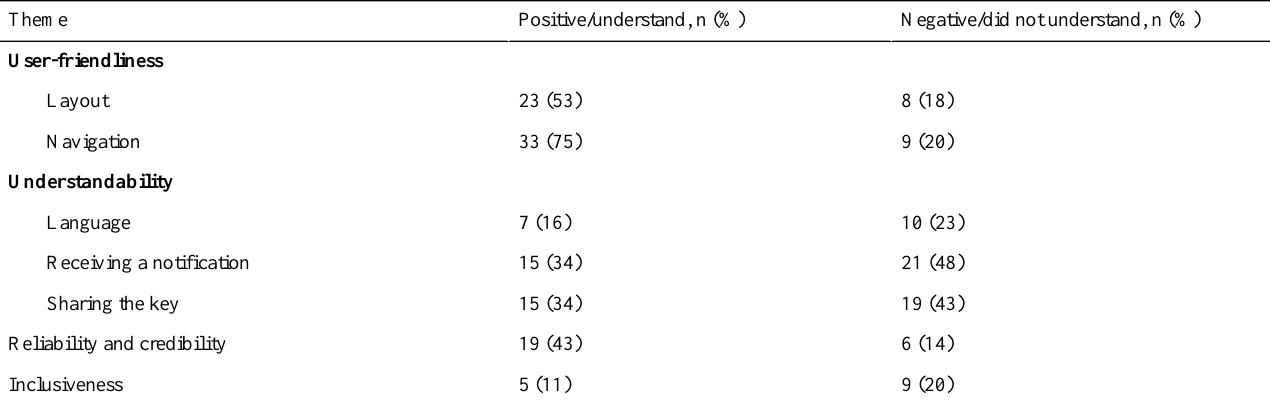
Table 2. Number of participants who stated a positive or negative comment about the CoronaMelder per topic (user-friendliness, understandability, reliability and credibility, and inclusiveness). For understandability of the notification and key-sharing system, the table demonstrates how many participants understood how the CoronaMelder app worked.